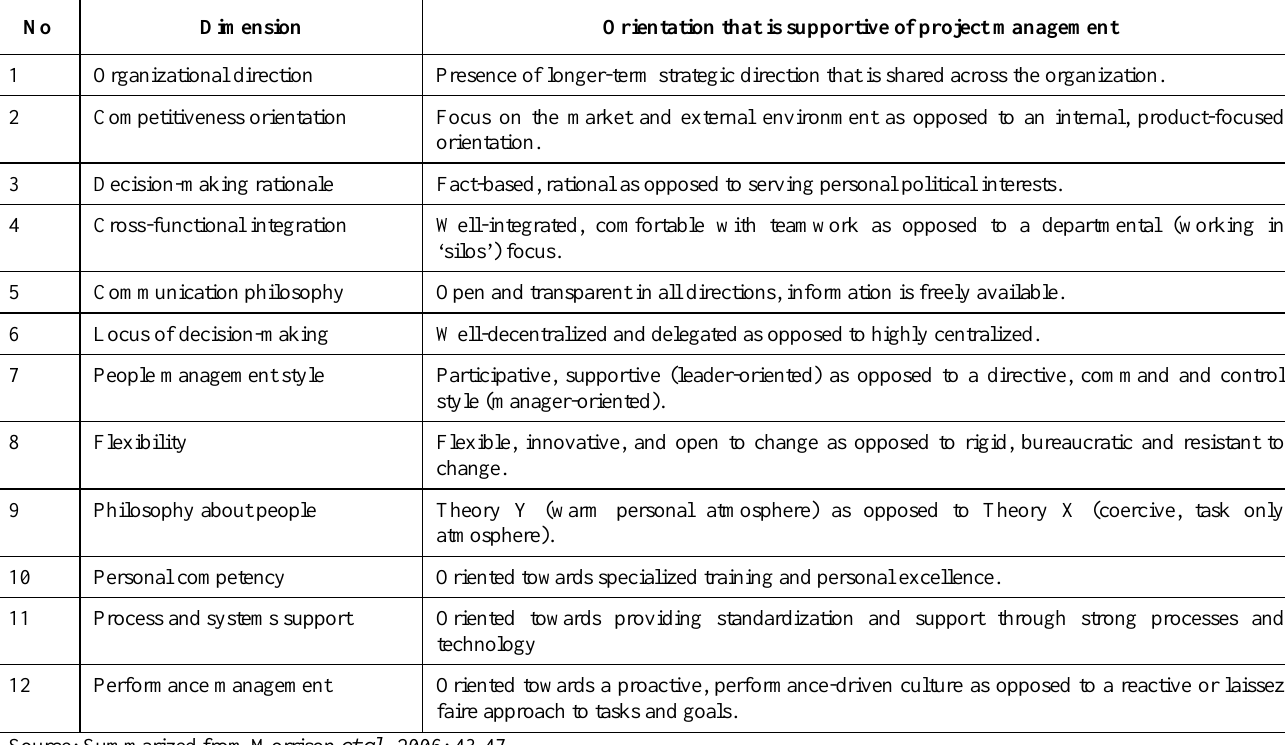
Table 1: Definition of the organizational culture construct